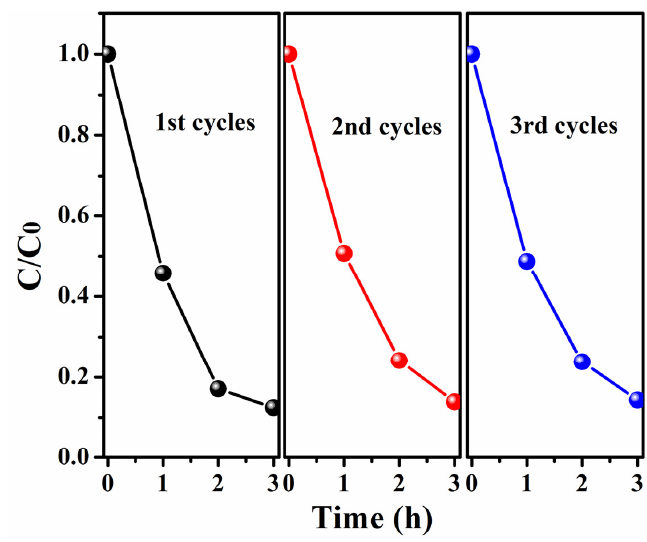
Figure 8. Photocatalysis tests of BiOI/TiO 2 ‐ C30 for three cycles.